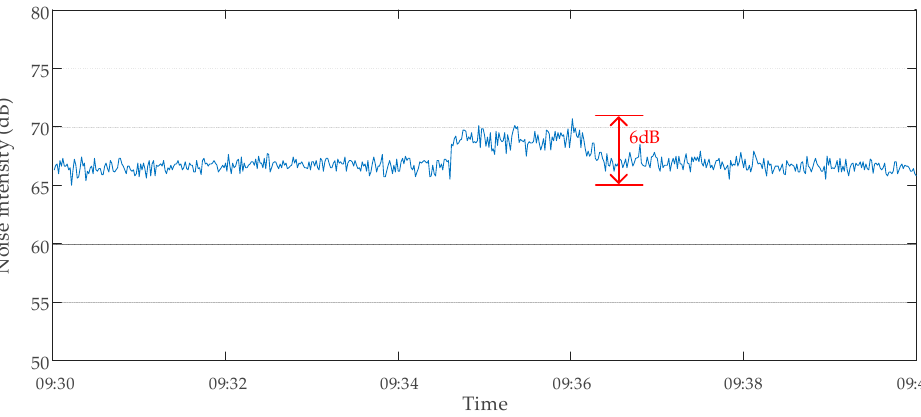
Figure 16. Monitoring data of noise intensity of transformer E on 5 November 2019.